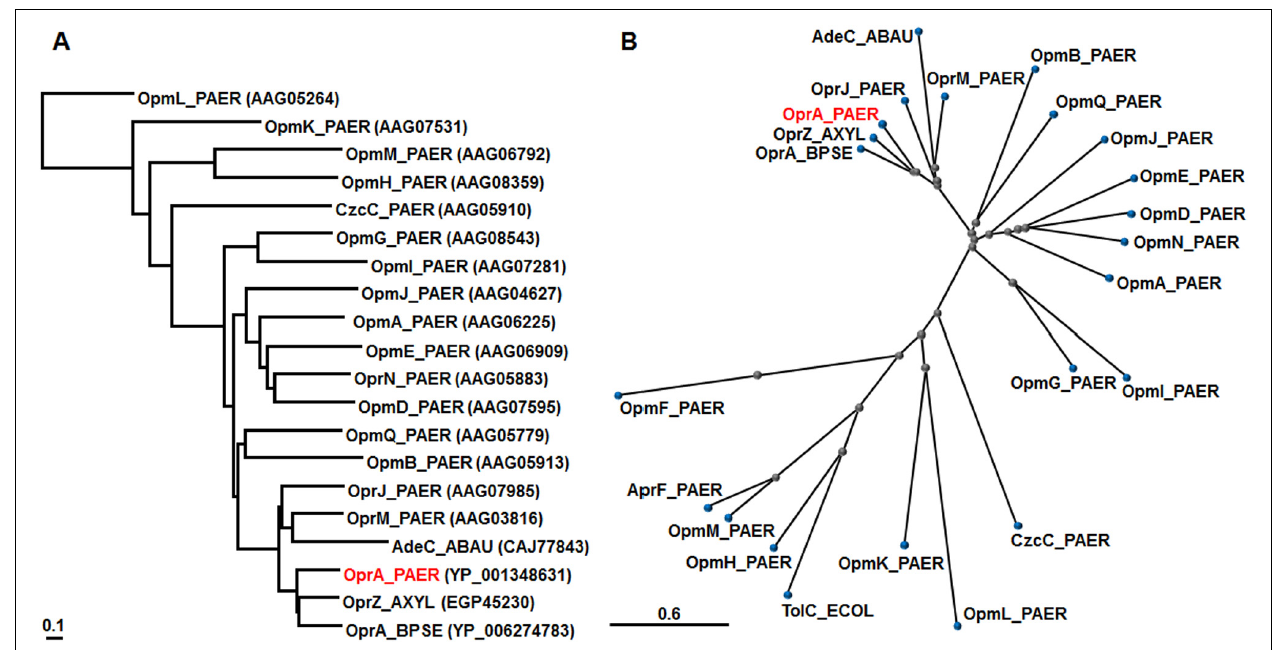
FIGURE 2 | Phylogenetic trees for representative OMPs. According to the COBALT program, the trees were constructed using the Fast evolution method and rendered with (A) Rectangle and (B) Radical. Protein names are abbreviated; for example, “OprA_PAER” stands for “OprA of P. aeruginosa .” Accession numbers are shown in